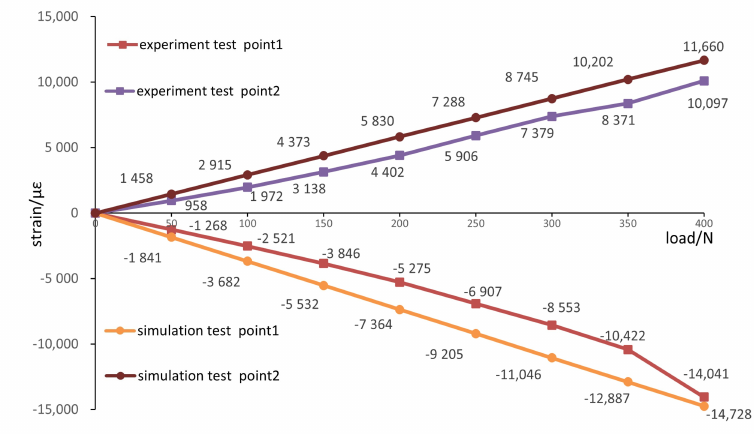
Figure 13. Comparison of experimental and simulated strain